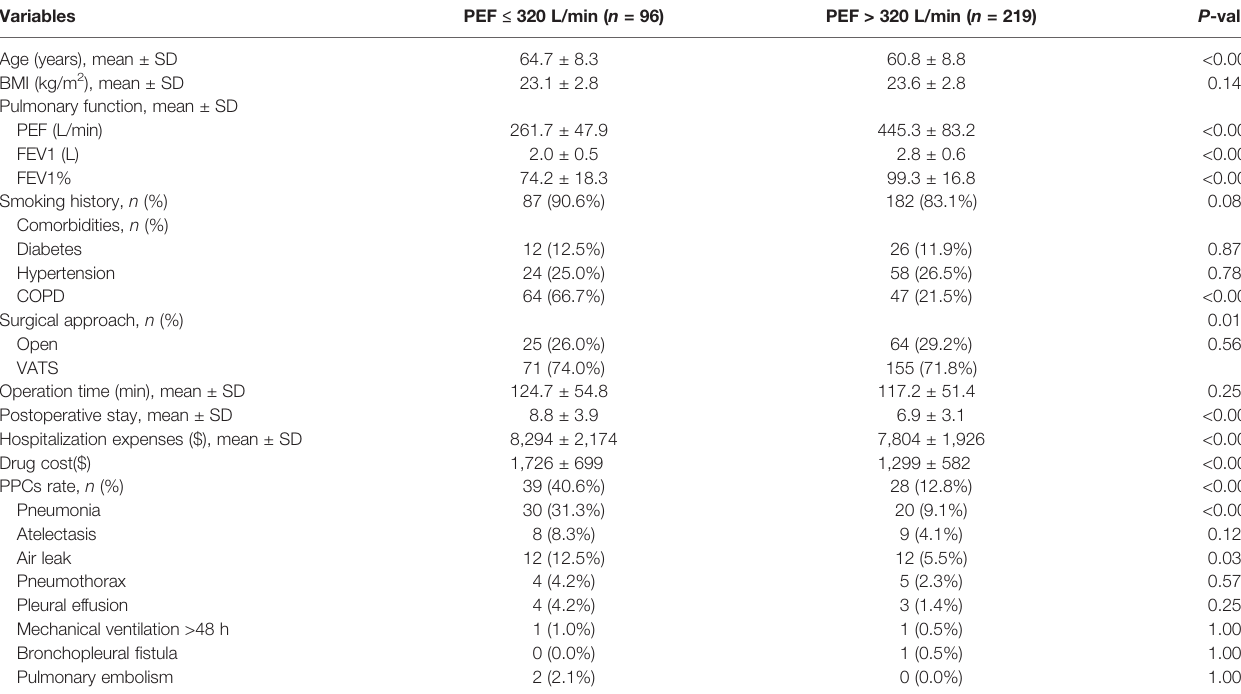
TABLE 4 | Clinical characteristics and outcomes between male patients divided by cutoff value of PEF.